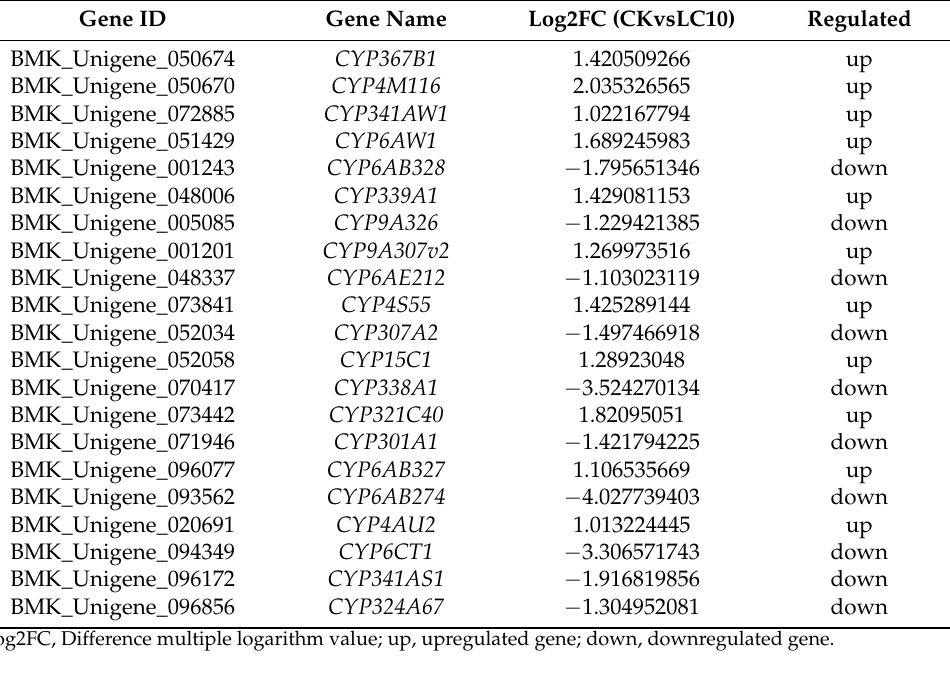
Table 4. Differential expression of the P450 gene.